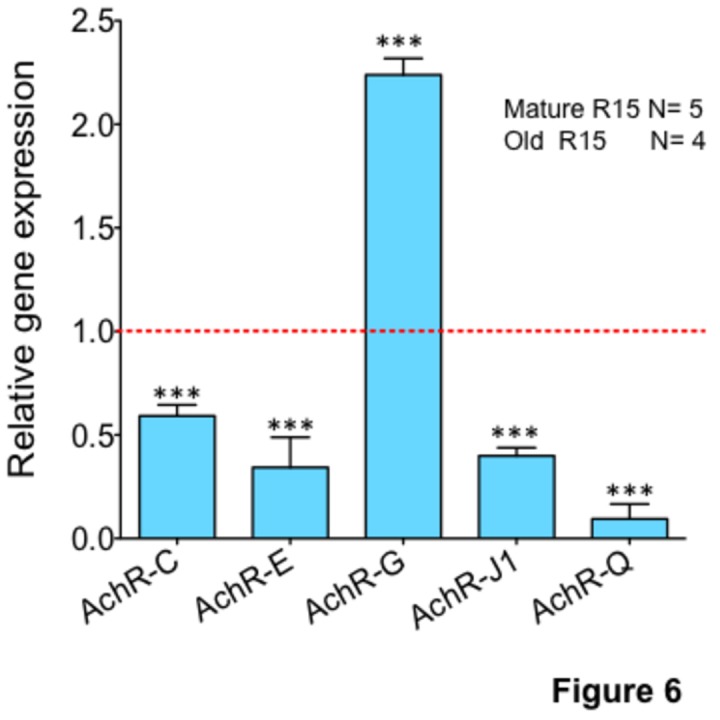
Quantitative analysis of AChRs in single R15 neurons from mature and old animals.RNAs isolated from single R15 neurons were amplified and used for qPCR analysis. Data was normalized to 18S rRNA levels. Relative expression of five AChRs in old R15 neurons is shown in bar graphs. Fold change ± SEM are shown. One way ANOVA and Tukey’s HSD post hoc test was used to determine the statistical significance where **p value < 0.01, ***p value < 0.001.